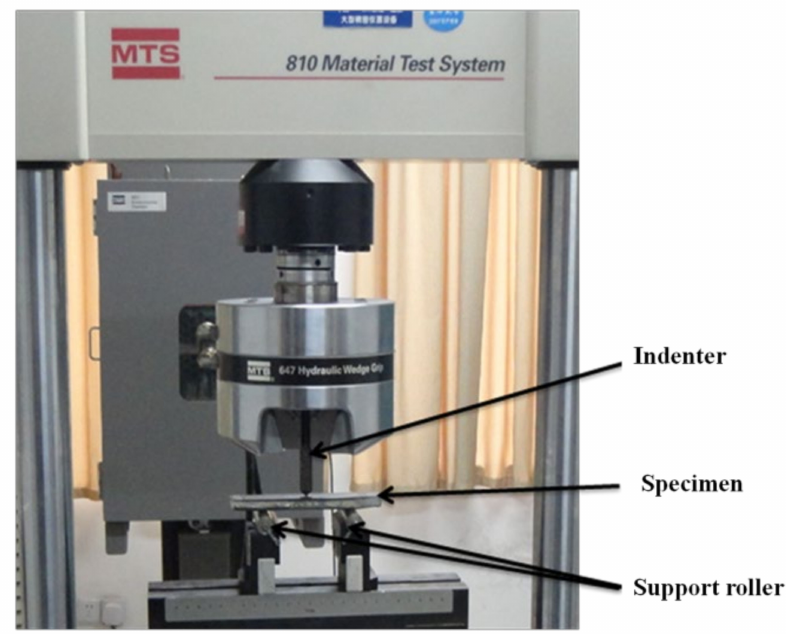
Figure 2. Three-point bending test using an MTS